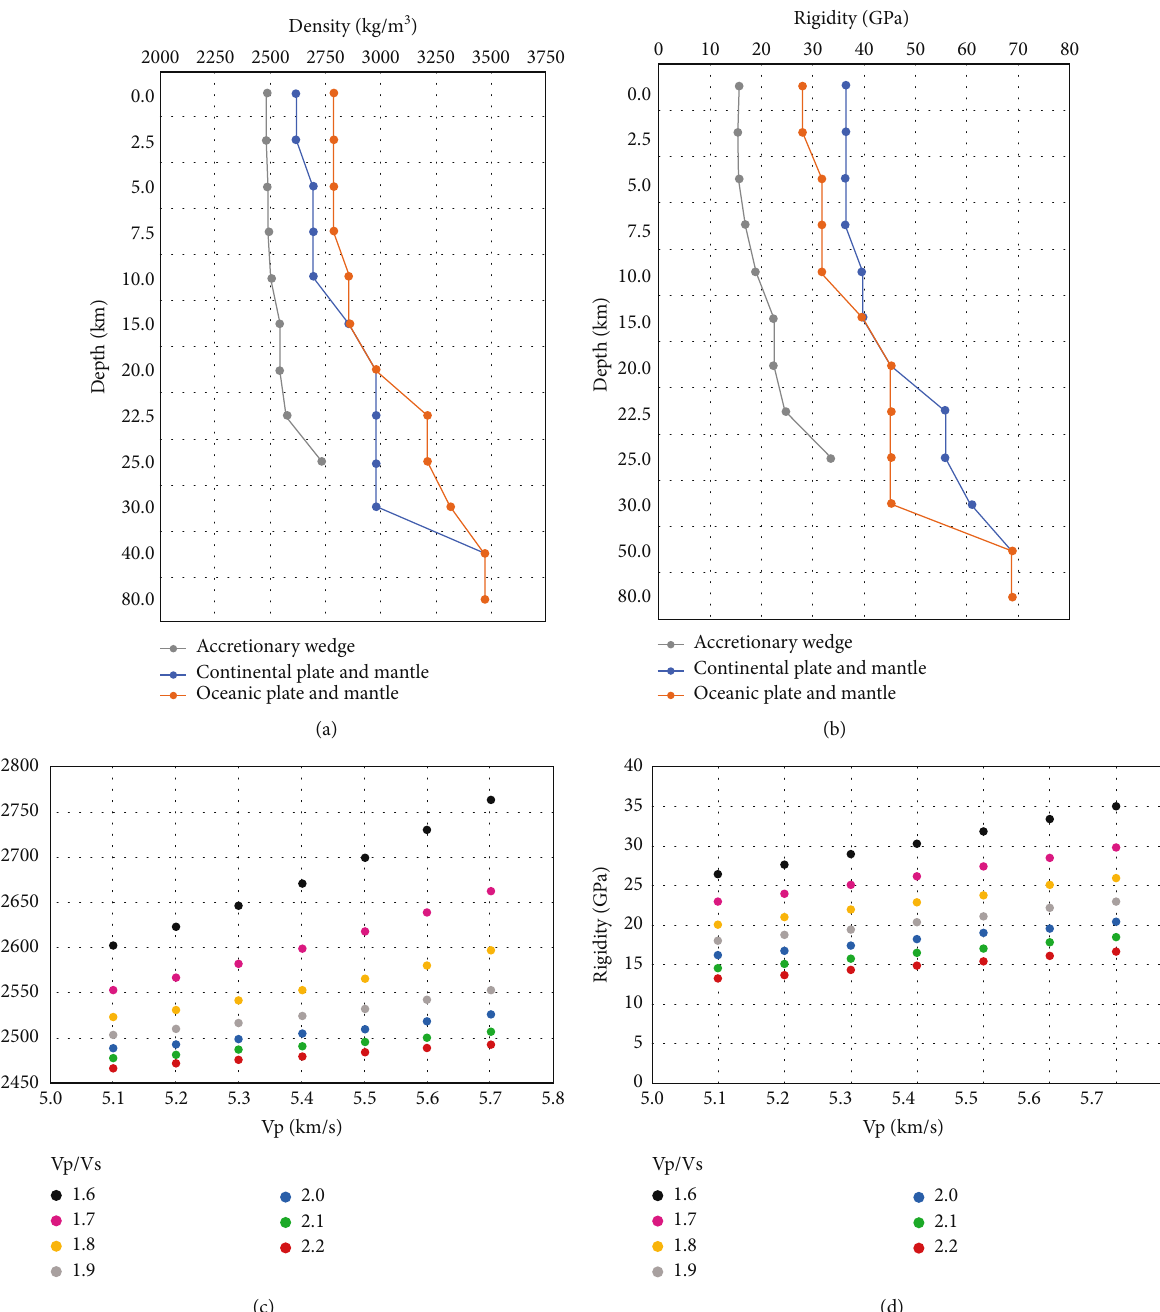
Figure 4: The density and rigidity resulted from the Vp and Vs values in Figure 3. (a) The density of the accretionary wedge (gray line), continental plate and mantle (blue line), and oceanic plate and mantle (orange line). (b) The rigidity of the accretionary wedge (gray line), continental plate and mantle (blue line), and oceanic plate and mantle (orange line). (c) The density of the accretionary wedge for the single material variation model obtained from Vp variation (5.1-5.7 km/s) and Vp/Vs ratio 1.6 (black dot), 1.7 (pink dot), 1.8 (yellow dot), 1.9 (gray dot), 2.0 (blue dot), 2.1 (green dot), and 2.2 (red dot). (d) The rigidity of the accretionary wedge for the single material variation model obtained from Vp variation (5.1-5.7km/s) and Vp/Vs ratio 1.6 (black dot), 1.7 (pink dot), 1.8 (yellow dot), 1.9 (gray dot), 2.0 (blue dot), 2.1 (green dot), and 2.2 (red